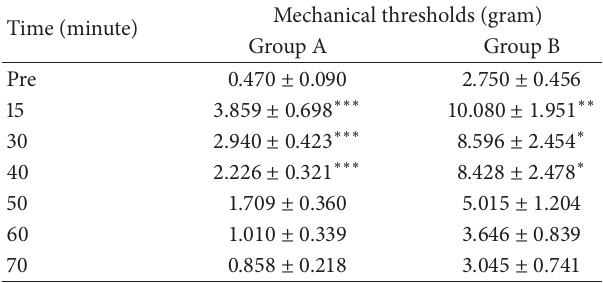
Comparisons among groups were made using repeated measures one-way analysis of variance (ANOVA). ∗∗∗ 𝑝 < .001 , ∗∗ 𝑝 < .01 , and ∗ 𝑝 < .05 for comparisons.